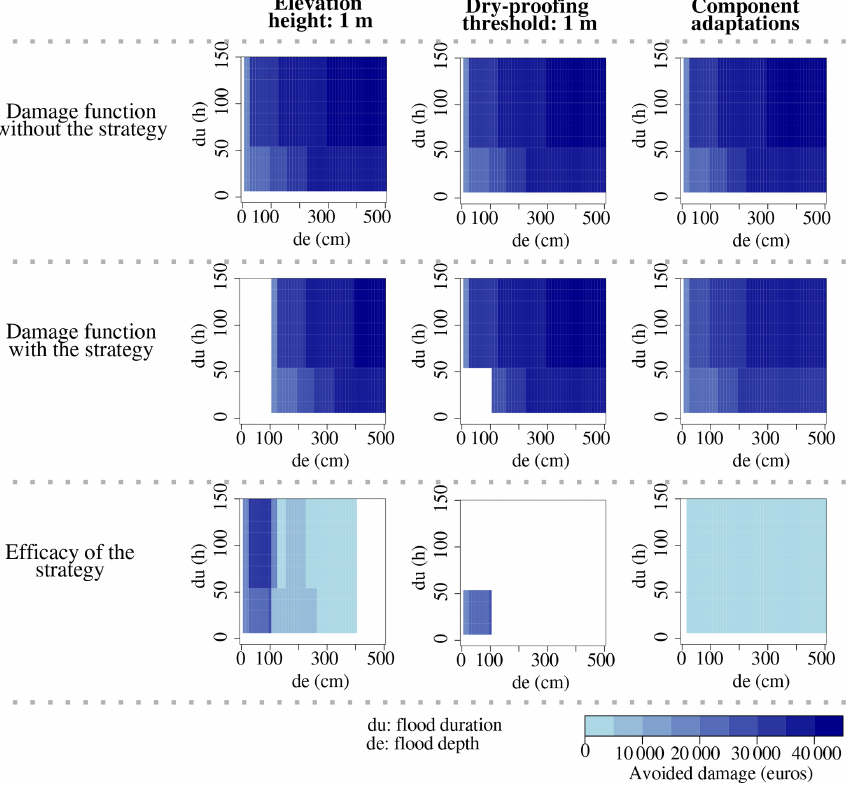
Figure 2. Efficacy of the elevation, dry proofing, and component adaptation strategies implemented on the original version of the single-storey house. The two top panels show damage in euros, while the lower panel shows avoided damage in